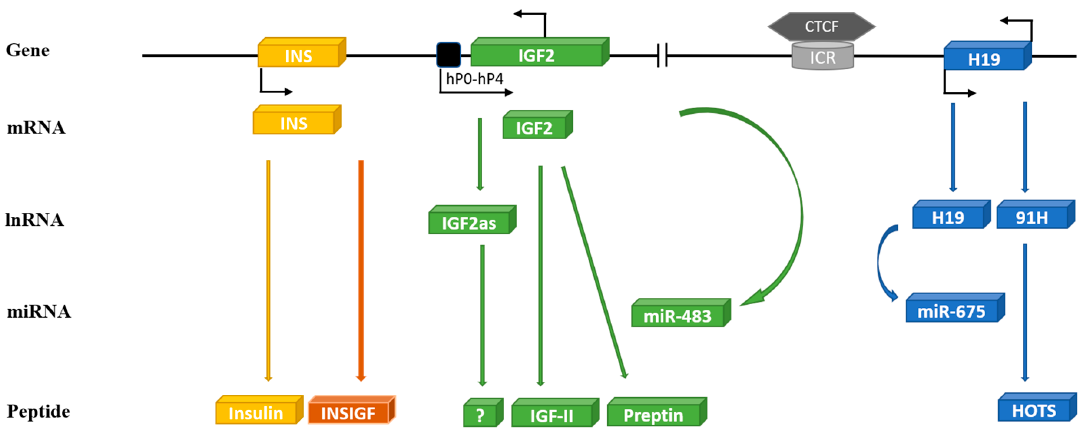
Figure 1. Schematic diagram of the human INS/IGF-II/H19 cluster genes on chromosome 11. The human IGF-II gene (consists of 10 exons) is transcribed into different mRNA transcripts originating from five unique promoters (P0-P4): IGF-II reverse transcribed yields IGF-II anti-sense (IGF-IIas) and micro RNA—miR-483. Human IGF-II mRNA translates to IGF-II peptide and preptin. The INS gene is located only 1.4 kb upstream from IGF-II consisting of three exons coding for insulin and INSIGF. The H19 gene is located 128kb downstream of IGF-II linked to it by an imprinting control region (ICR) to which a transcriptional regulator CCCTC-binding factor (CTCF) can bind and regulate imprinting of IGF-II/H19. The human H19 gene transcribes in a sense direction to yield long non-coding H19 and micro RNA—miR-675 or in antisense direction to 91H, which translates to H19 opposite tumor suppressor (HOTS).